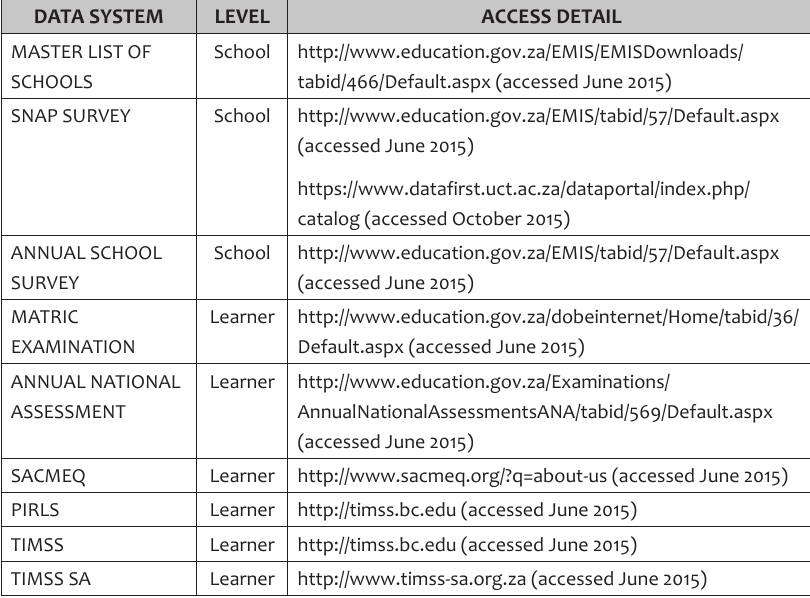
Table 7: Main large-scale education data sets DATA